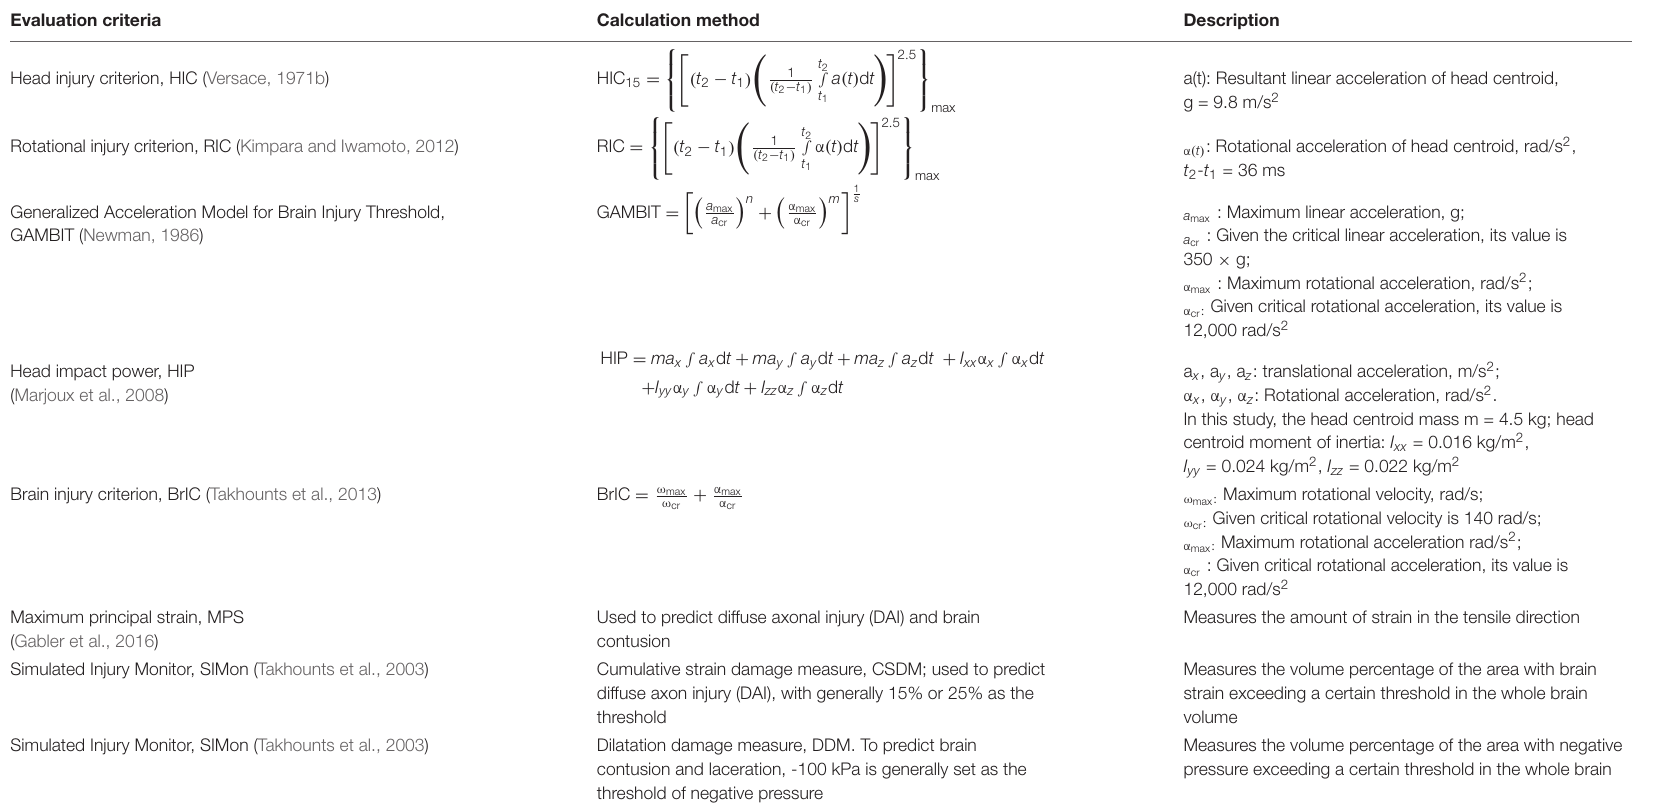
TABLE 3 | Evaluation criteria of head